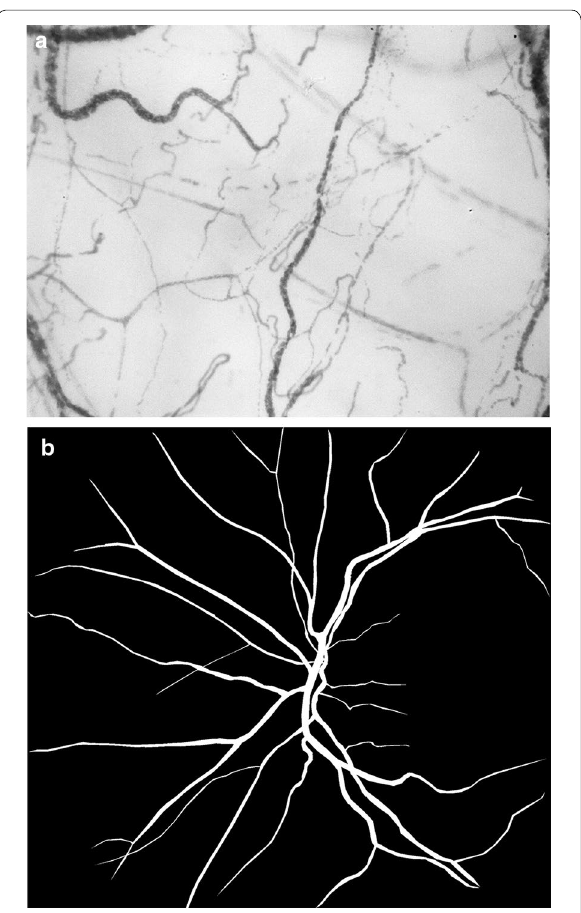
Fig. 1 Images of ocular microvasculature at baseline in septic patient: a conjunctival microcirculation, b manually segmented retinal vascular networks of septic